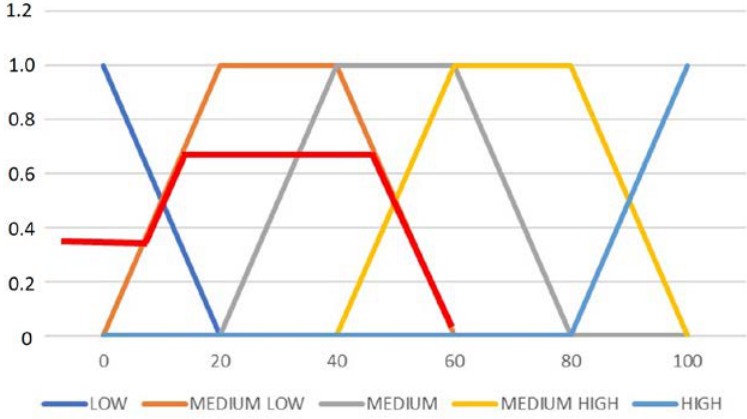
Figure 17. Aggregation of rules for design for manufacturing organization 1.